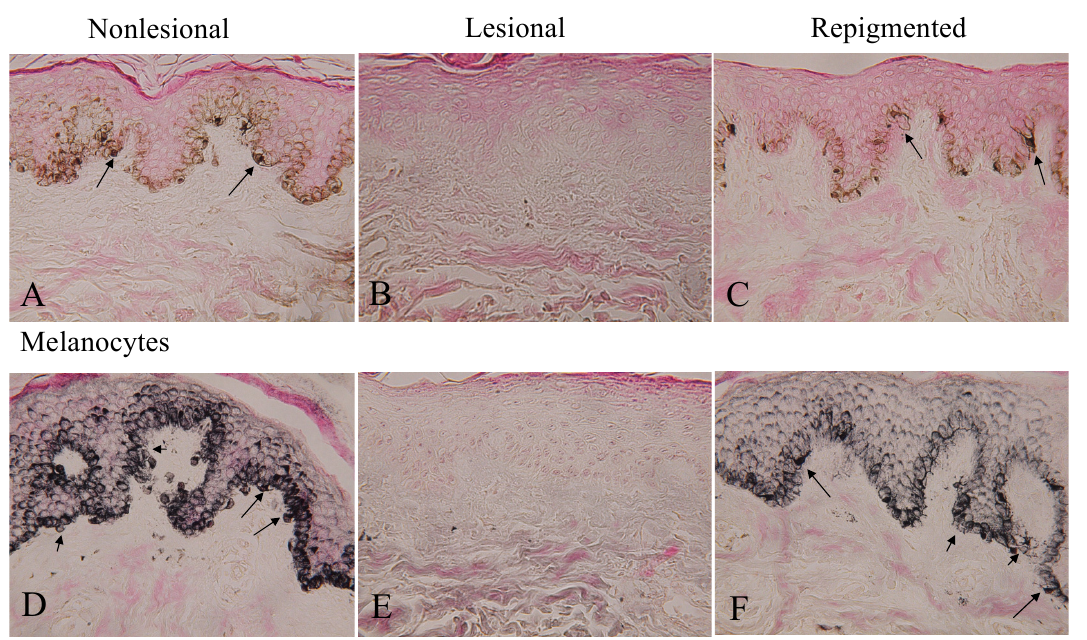
Figure 2. The dopa reaction of nonlesional belly skin ( A ) of patient No. 1 reveals many tyrosinase- positive melanocytes (long arrows) with well-developed dendrites. Melanoblasts (short arrows) and melanocytes (long arrows) positive to the combined dopa–premelanin reaction are also observed ( D ). By contrast, no melanocytes ( B ) and melanoblasts ( E ) are observed in the lesional skin. However, many dendritic melanocytes ( C , long arrows) and melanoblasts (short arrows, F )/melanocytes (long arrows, F ) are observed in the repigmented skin. Although epidermal melanin pigmentation in the repigmented skin is lower than in the nonlesional skin, the number of melanocytes is comparable to that of nonlesional skin. Original magnification level, ×400.